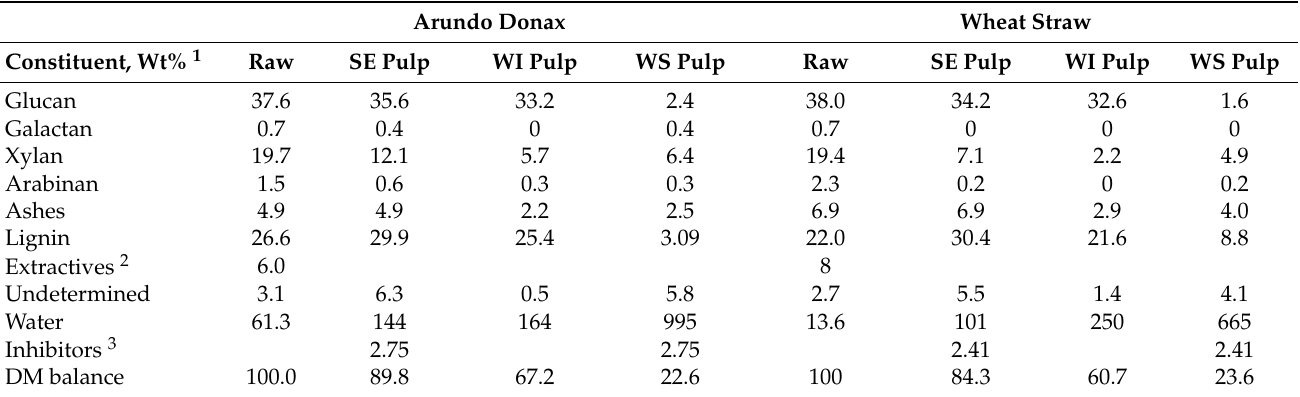
Substrates composition and flow of the constituents after SE and water washing (WI = water-insoluble, WS = water